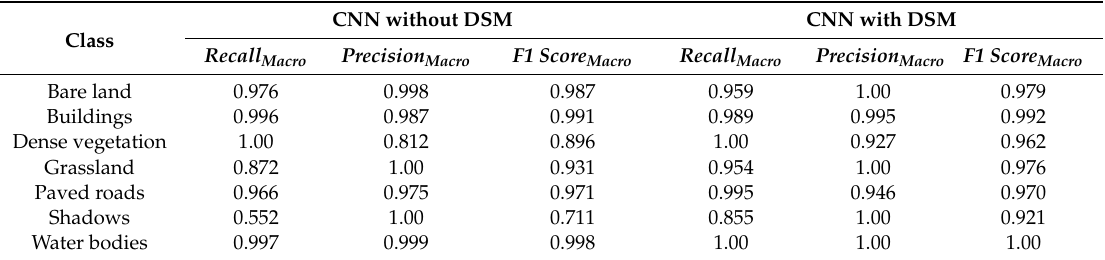
Table 5. Recall, Precision, F1 Score obtained using CNN with DSM and CNN without DSM.